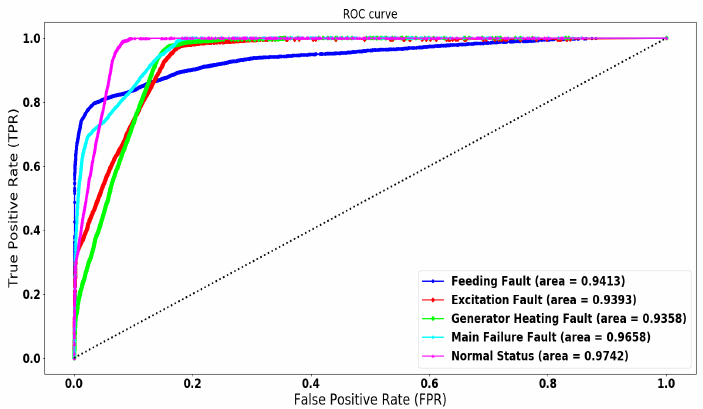
Figure 6. In this plot we provide the Receiver Operating Characteristic (ROC) Curves for the 5 category multiclass fault detection problem, exploiting the LSTM-SAE scheme. Specifically, for the different categories our proposed deep feature learning/classification scheme achieves the following performance: Area Under Curve (AUC)-Feeding Fault: 0.94, AUC-Excitation Fault: 0.93, AUC-Generator Heating Fault: 0.93, AUC-Main Failure: 0.96, and finally AUC-Normal: 0.97. Since all ROC Curves are over 90%, we are able to justify our assumption that the proposed LSTM-SAE scheme provides highly accurate classification results.